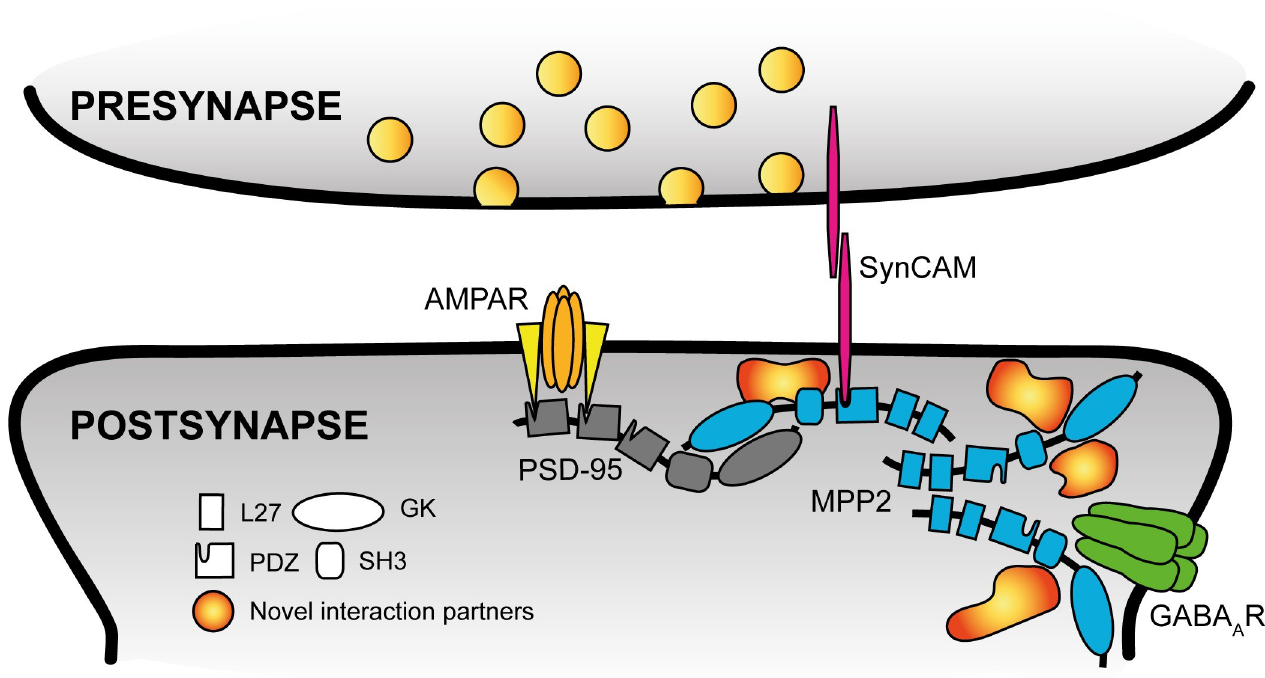
Fig 9. Schematic summary of novel MPP2 interactors. Our data indicate an important role of MPP2 (blue) in the subsynaptic compartmentalisation of dendritic spines by connecting central components of AMPA receptor (orange) complexes, like TARPs (yellow) and PSD-95 (grey) not only to cell adhesion proteins like SynCAM 1 (magenta) and other scaffold and regulatory proteins (like the novel interaction partners PIP5k1c or Ppp3ca), but most importantly inhibitory GABA A receptors (green). For MAGUK proteins, the individual domain structure is indicated. GABA, γ -aminobutyric acid; MAGUK, membrane- associated guanylate kinase; MPP2, membrane protein palmitoylated 2; PSD, postsynaptic density.